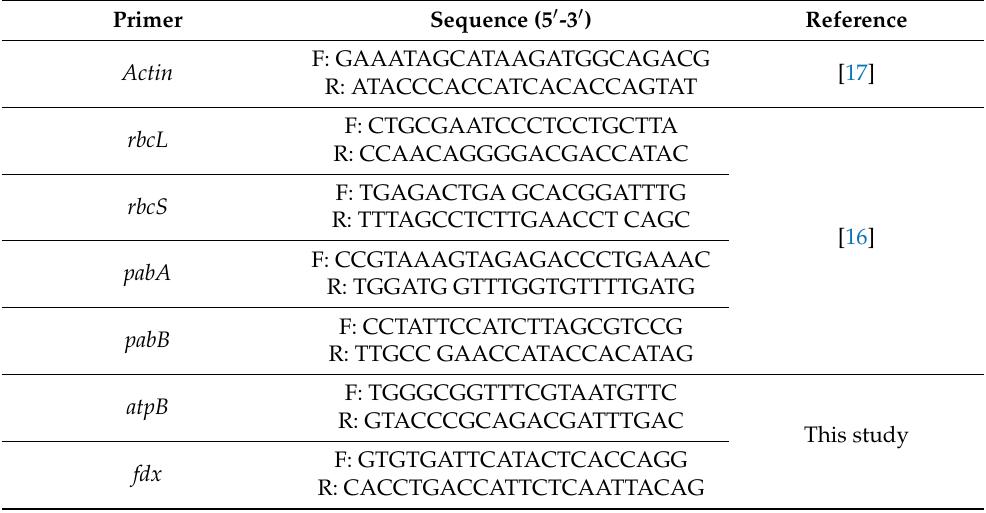
Table 1. The primer sequence of the tomato on photosynthetic-related genes.